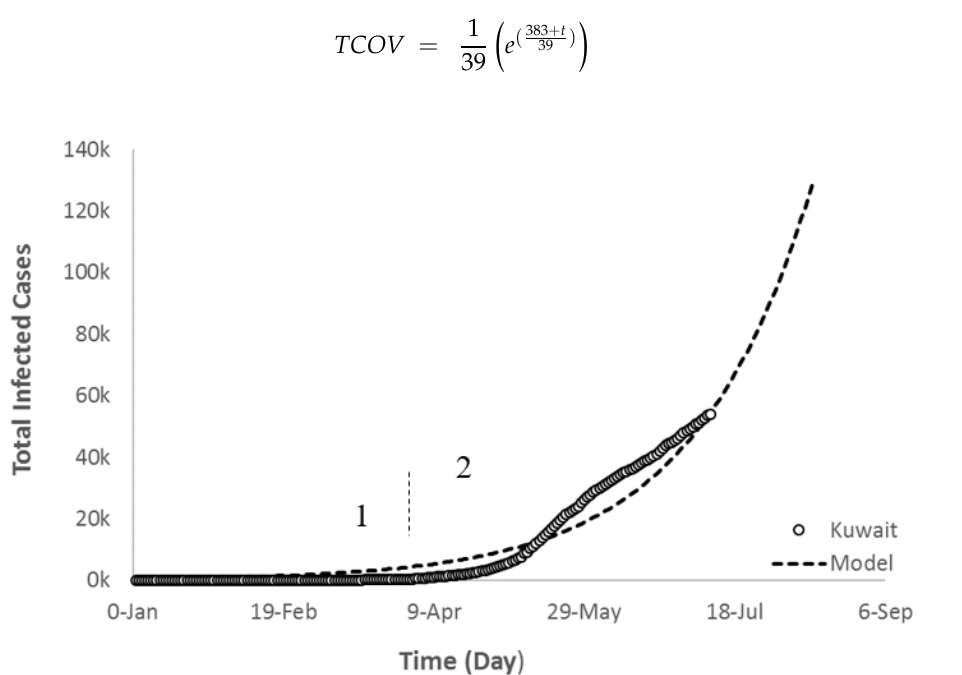
Figure 21. Exponential growth regression fit of Kuwait’s current and future trajectory of COVID-19 total infected cases.